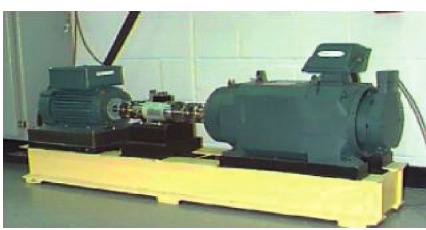
Figure 4: CWRU experimental